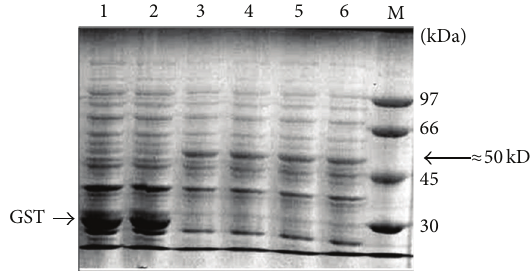
Figure 1: GST-EGFR expression in E. coli BL21 strain. The proteins were separated in a 10% SDS-PAGE and stained with Coomassie blue. (Lanes 1 and 2) Two clones of E. coli BL21 cells transformed by emptypGEX-6P-1vector. (Lanes3–6)Differentclonesof E. coli BL21 cells transformed by pGEX-EGFR. (Lane M) The protein masses of the BioRad markers are indicated in kDa. The arrows point to GST and the ≈ 50 kDa